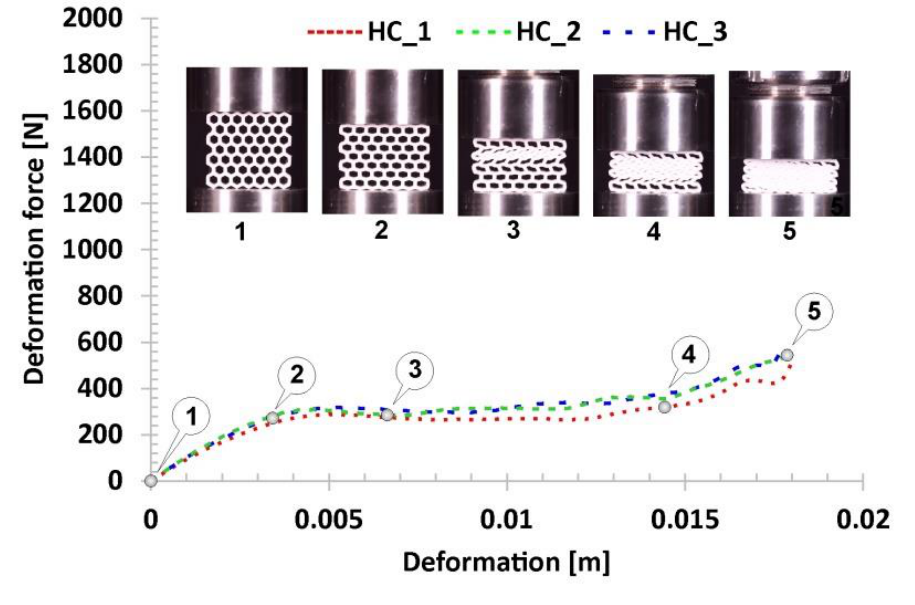
Figure 13. The results of the compression tests of the structural specimen with regular honeycomb topology.